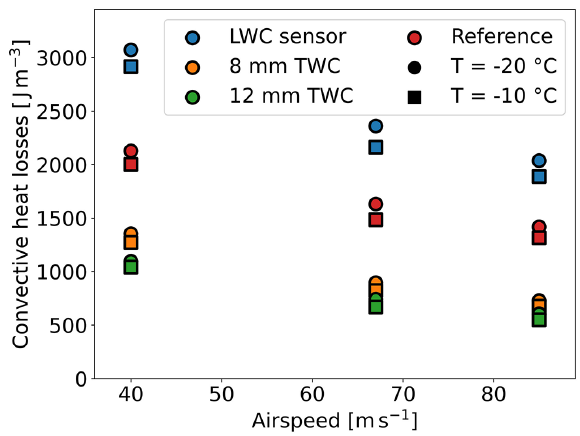
Figure A1. Convective heat losses of the Nevzorov sensors per vol- ume of air. The volume of air that a sensor is exposed to is computed from the sample area and the airspeed. Turbulence and blockage ef- fects that may occur around the sensors are not considered for this